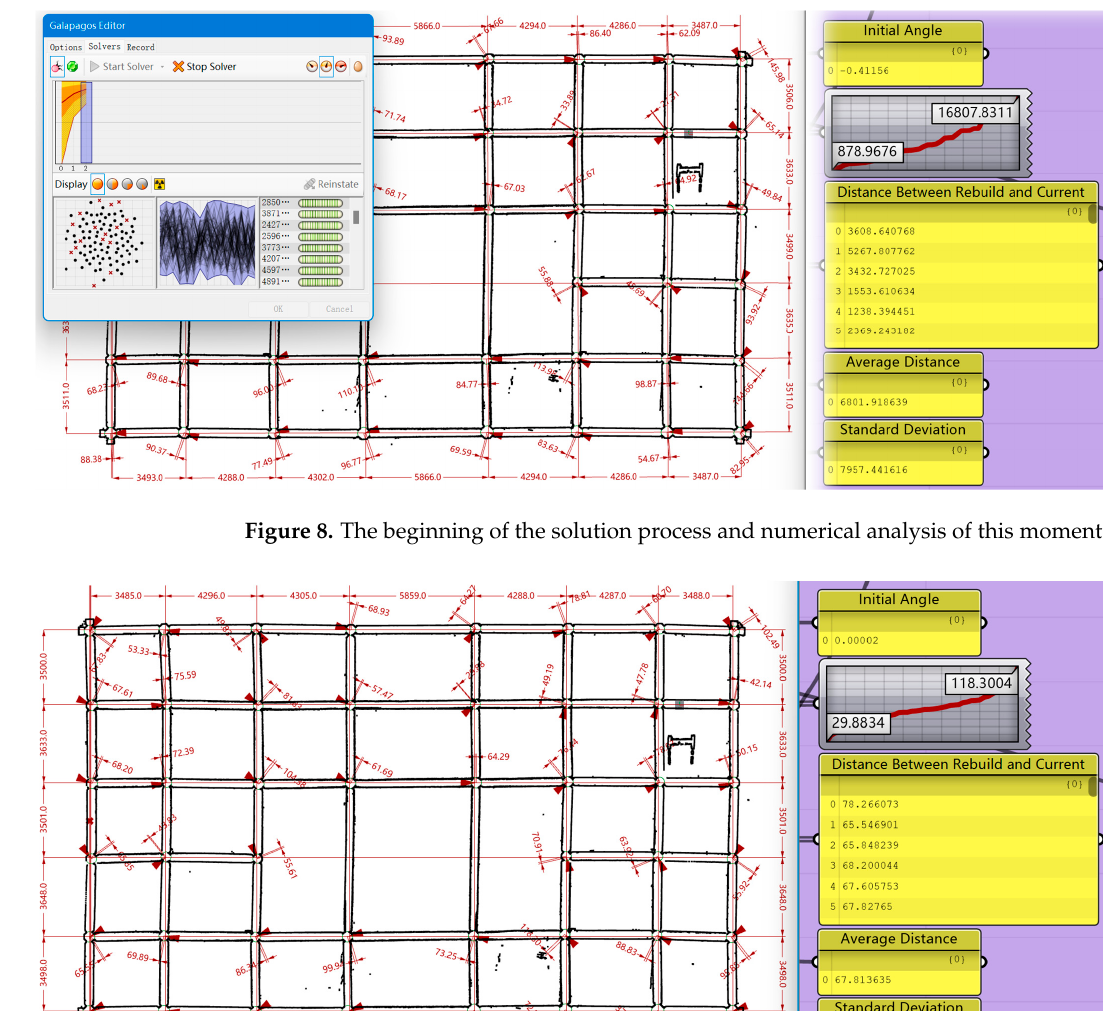
Appl. Sci. 2022 , 12 , x FOR PEER REVIEW Figure 7. Connect Gauss sum to fitness (blue wire) for genetic algorithm solution.